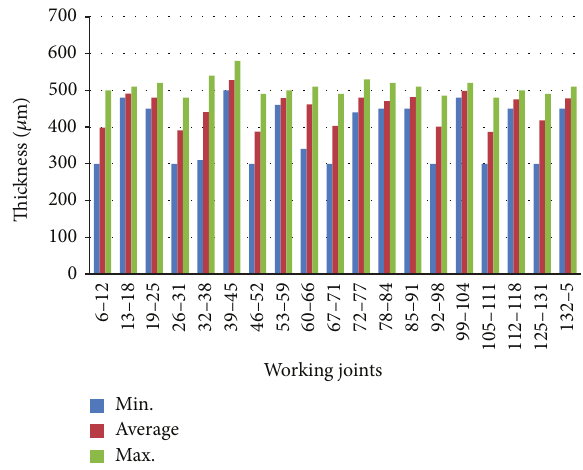
Figure 15: Classification of the cross-cut test (standard ISO 2409: 1992